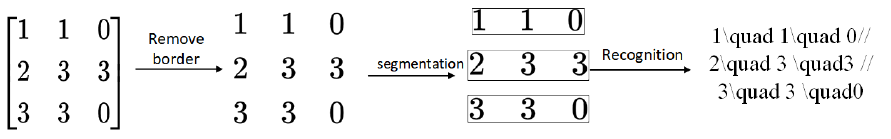
Figure 8. YOLO detection results.